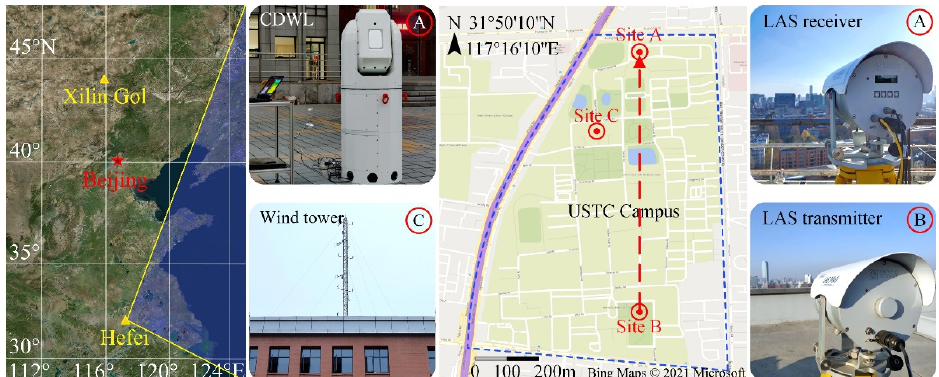
Figure 1. Illustration of two experiment sites in the satellite map and the instruments layout in the horizontal experiment (USTC, Hefei City).